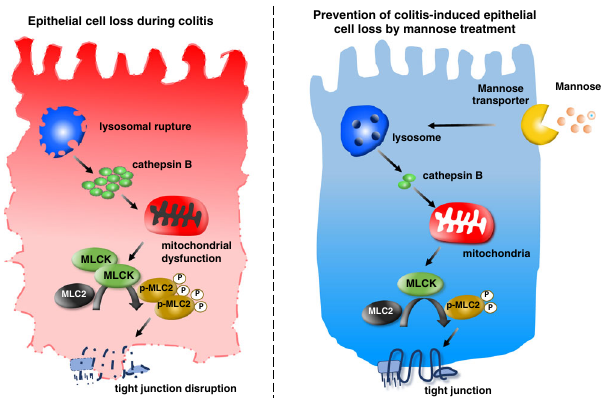
Fig. 8 | A model of the proposed mechanism by which mannose protects against colitis. The proposed scheme shows that mannose protects lysosomal integrity and subsequently limits the release of cathepsin B, leading to the pre- vention of mitochondrialdysfunctionand MLCK-induced tightjunction disruption in response to intestinal epithelial cell damage during